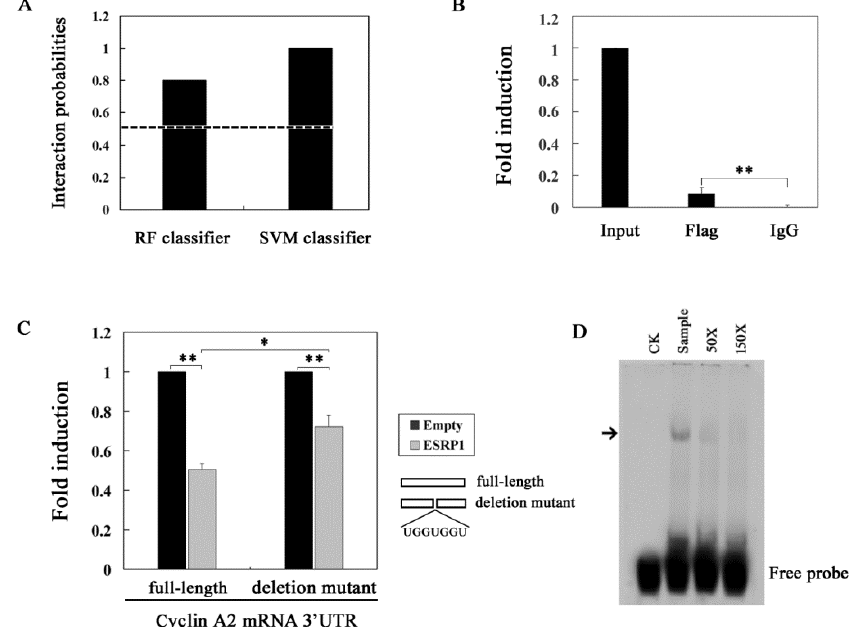
Figure 4. ESRP1 binds the cyclin A2 mRNA 3’UTR. ( A ) RPISeq was used to predict the likelihood of interactions between ESRP1 and the cyclin A2 mRNA, with any probabilities greater than 0.5 being deemed “positive”, suggesting a likely interaction. ( B ) RIP was performed using antibodies against FLAG in ESRP1-overexpressing HeLa cells, with ESRP1-bound transcripts being analyzed via qRT-PCR. ( C ) HEk293 cells in 24-well plates were co-transfected with full-length or deletion mutant vector (0.5 µ g / well), along with ESRP1 vector (0.1 µ g / well), and after 48 h cells were lysed and luciferase activity was assessed. ( D ) EMSA was performed using RNA transcript probes and FLAG -ESRP1. Arrowheads indicate the RNA-protein complexes. Competition experiments with a 50- and 150-fold excess of unlabeled RNA transcript probes were also performed. For normalization of luciferase activity, the signal (1 µ g protein) for control cells was set to 1. This experiment was repeated three times ( n = 3); error bars indicate standard error; * p < 0.05, ** p < 0.01.